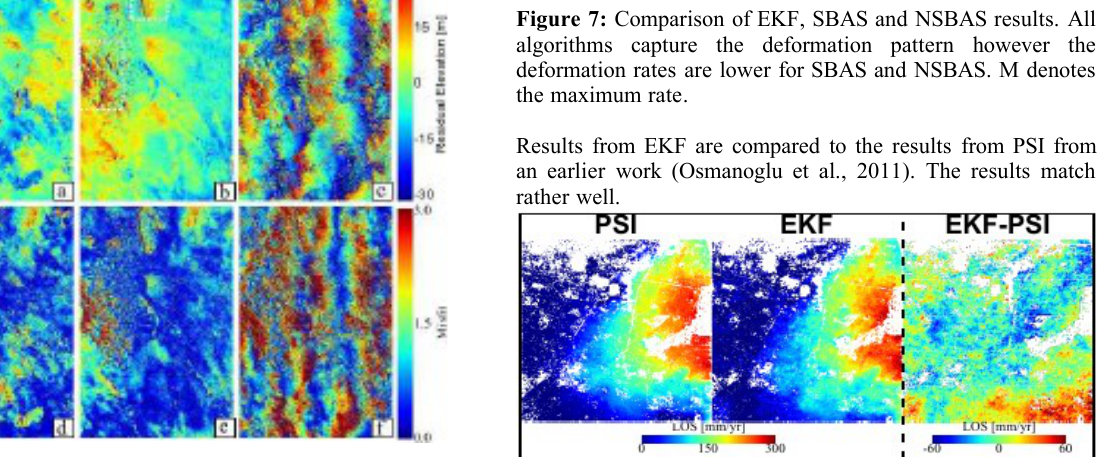
Figure 7: Comparison of EKF, SBAS and NSBAS results. All algorithms capture the deformation pattern however